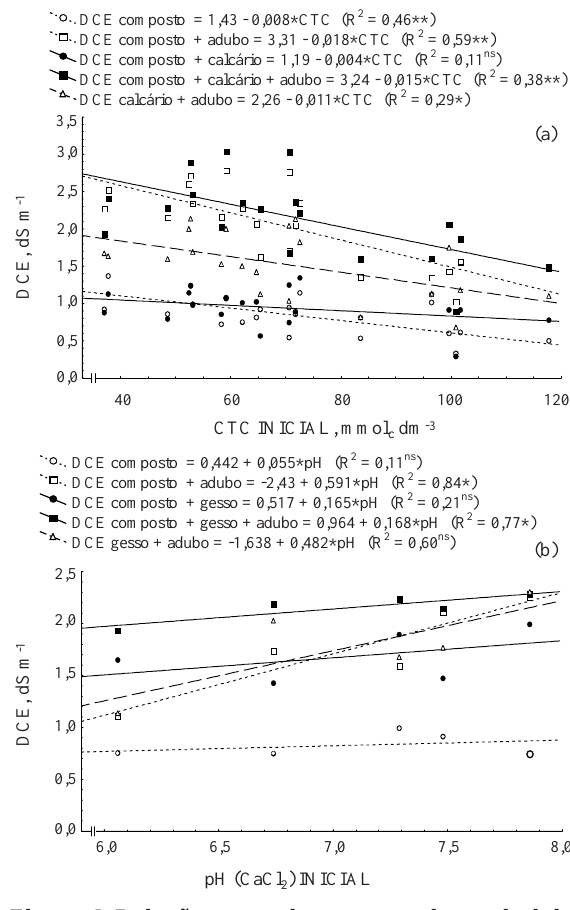
Figura 1. Relação entre o incremento da condutivi- dade elétrica (DCE) e capacidade de troca ca- tiônica (CTC) inicial em solos ácidos, tratados com composto de lixo, na presença ou ausên- cia de calcário dolomítico e adubos minerais (a), e pH inicial em solos alcalinos, em que o calcário foi substituído por gesso